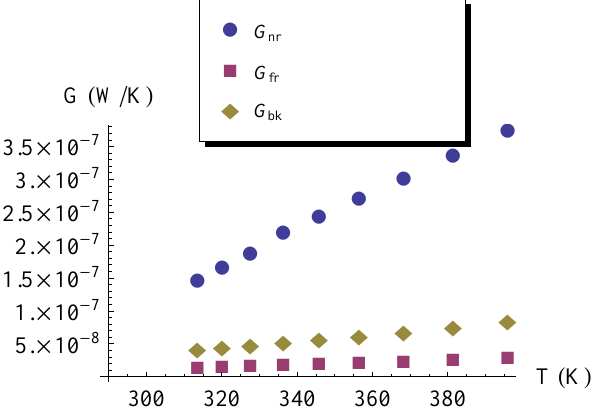
Figure 7. Temperature dependent heat transfer coefficient for far-field thermal radiation, blackbody radiation and experimental